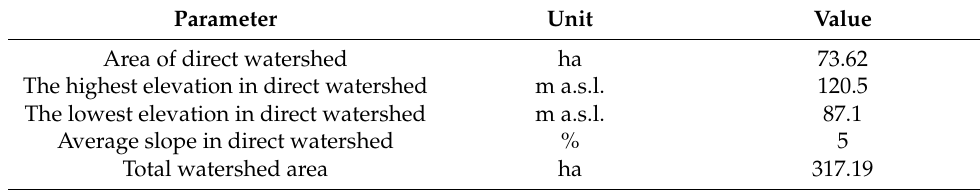
Table 3. Watershed characteristics of Nienawiszcz